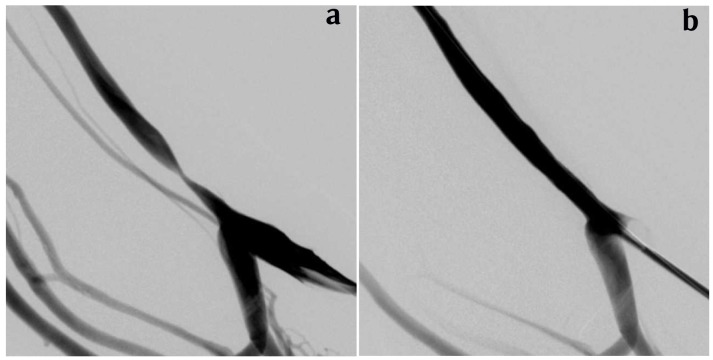
left cephalic vein before (a) and after (b) 7 × 40 mm PCB dilation.